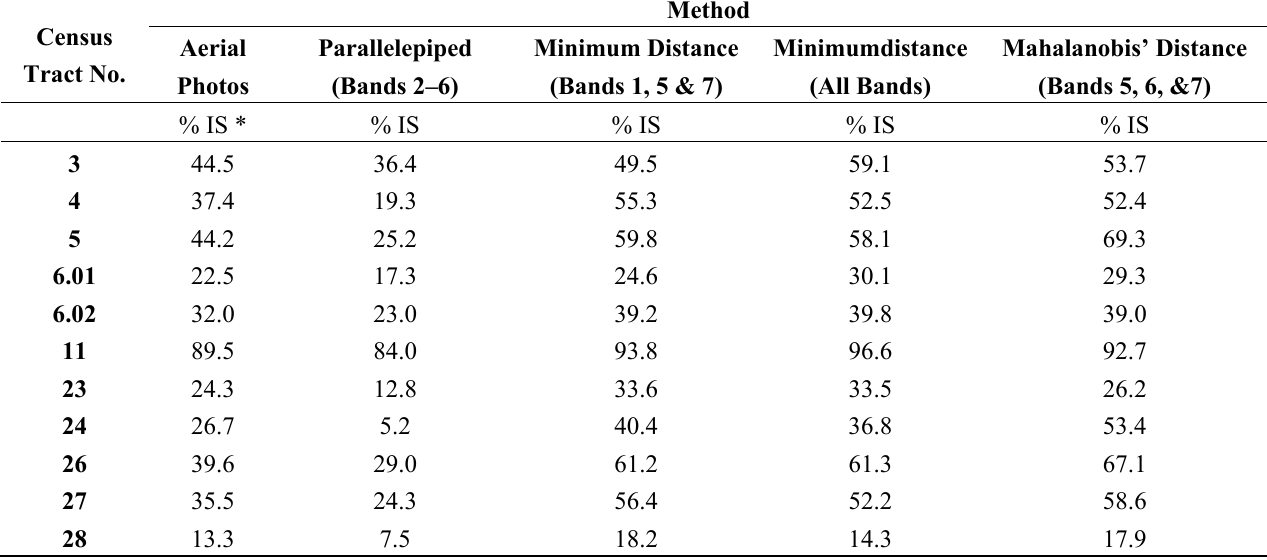
Table 5. Percent impervious for the manual delineation of aerial photos and percent impervious for each of the four chosen classification methods (Figure 3), and listed by census tract.